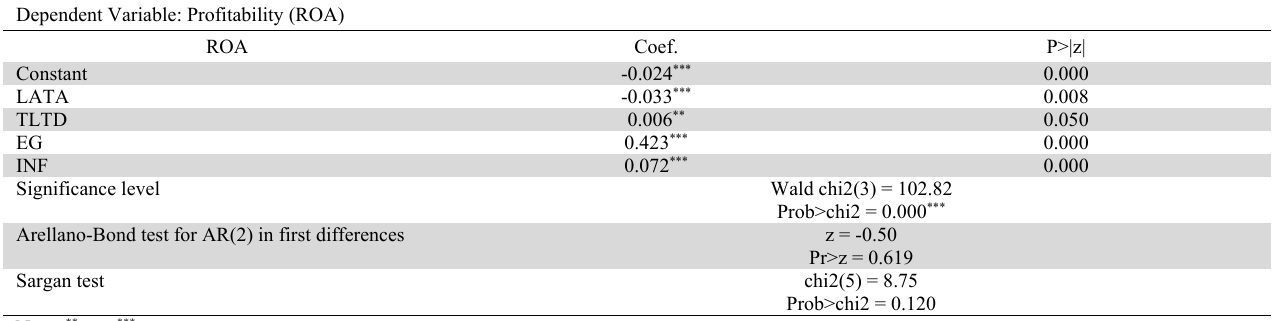
GMM estimation results